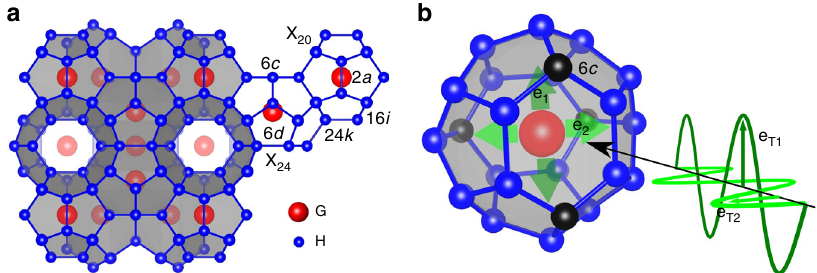
Fig. 1 Clathrate crystal structure. a Type-I clathrate crystal structure G 8 H 46 . Per unit cell 8 guest atoms (G, red) are situated in two different cages (smaller dodecahedra X 20 and larger tetrakaidecahedra X 24 ) built by the host (H, blue) atoms. The different crystallographic sites are labeled. b Sketch of an X 24 cage with the two soft rattling directions e 1 and e 2 within the easy plane parallel to the two hexagonal faces of the cage. Each soft direction is parallel to the longest secant of one of the two hexagons, both de fi ned by the 6 c site (black atoms) of the structure. Incoming acoustic phonons with the two different transverse polarizations e T1 and e T2 are sketched by the sinusoidal